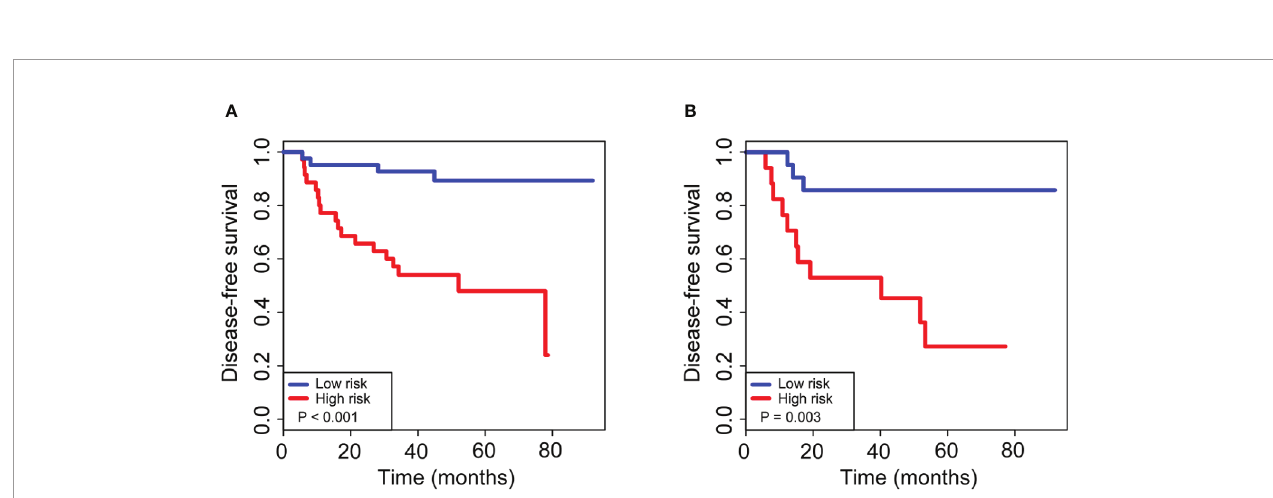
FIGURE 3 | Kaplan – Meier curves for 5-year disease-free survival in breast cancer patients who had residual tumors after neoadjuvant chemotherapy. For patients with high and low risks of DFS, strati fi ed by our newly developed radiomics signature, the 5-year survival rates were 89 and 86% for the low-risk group and 48 and 27% for the high-risk group, with a signi fi cant difference between groups (P < 0.01) in both the training (A) and validation (B) cohorts. The log-rank test was used to calculate the corresponding